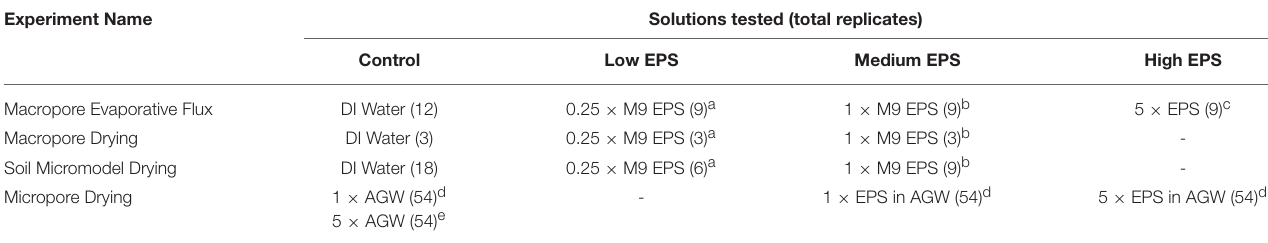
TABLE 1 | Summary of the different solutions used in each experiment including number of replicates across all relative humidity (RH) treatments.